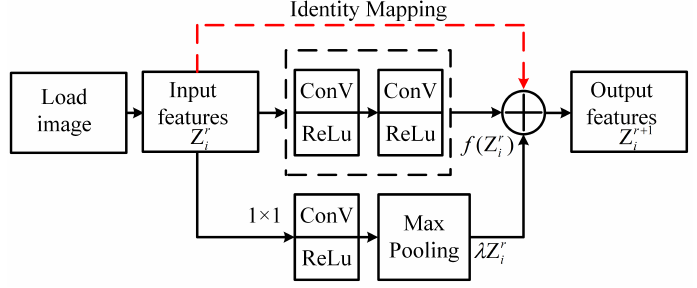
Figure 3. The weight residual structure of